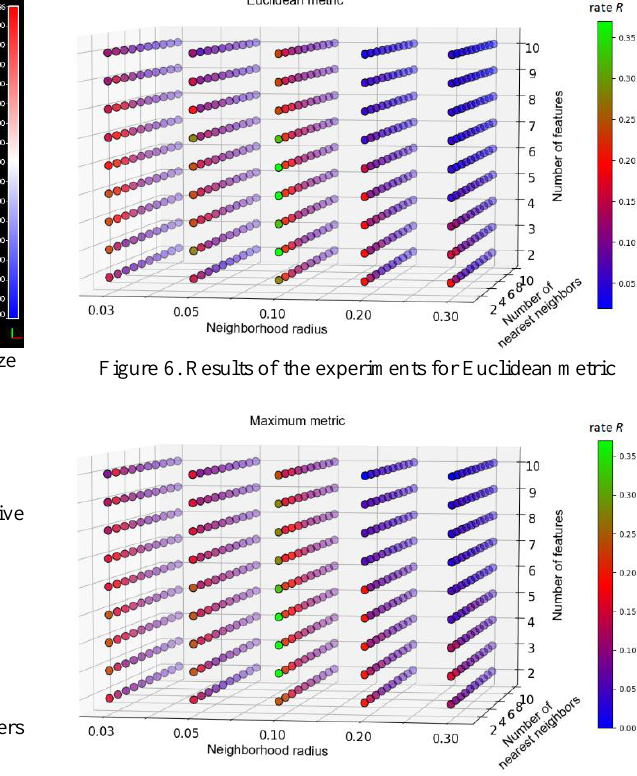
Figure 7. Results of the experiments for maximum metric